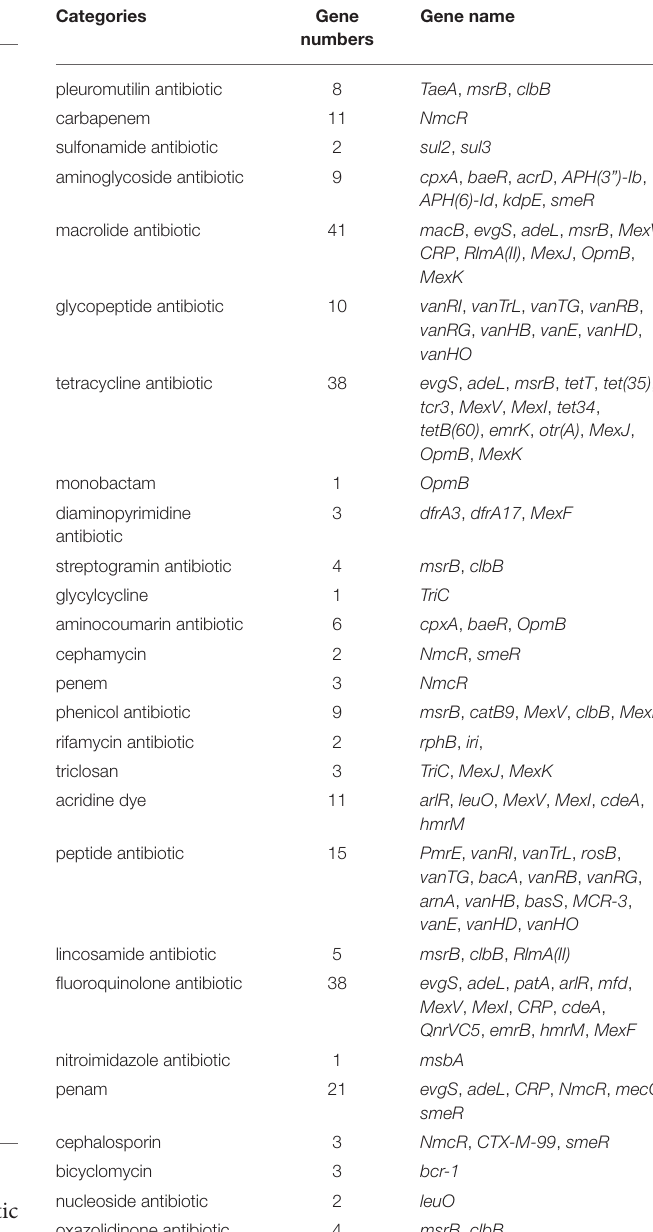
strain. Supplementary Table 5 shows antibiotic resistance genes additional information.